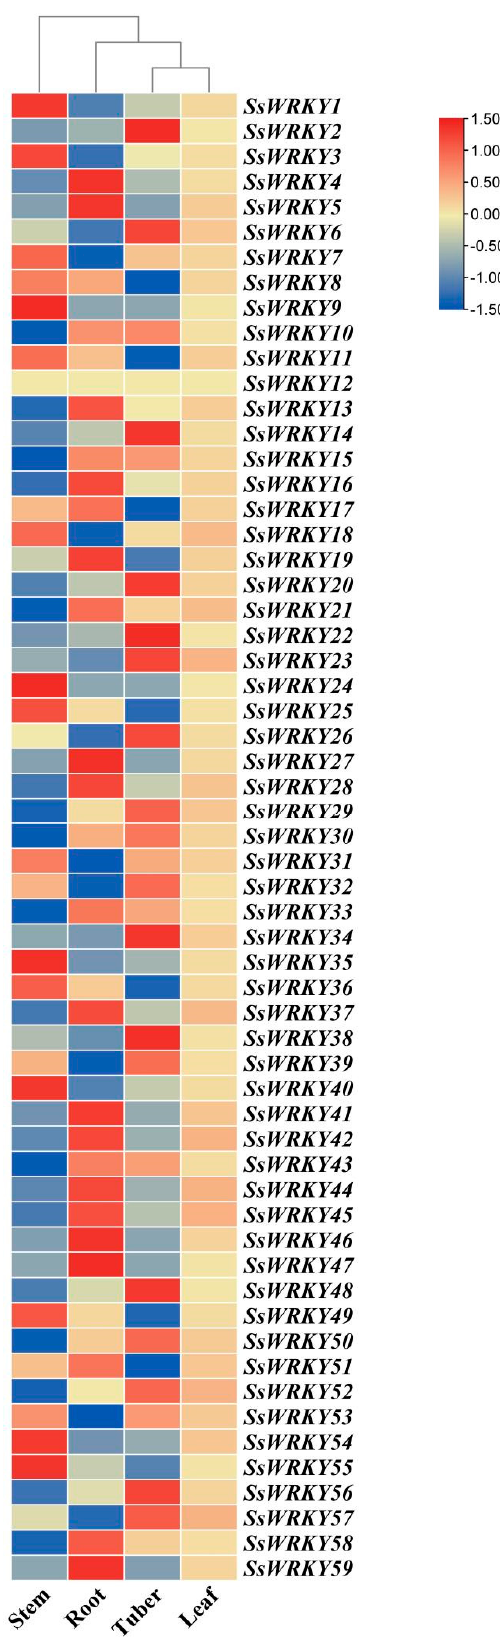
Figure 8. Expression patterns of SsWRKY genes in four different tissues of S. siamensis . RPKM value was assessed to investigate the expression levels of SsWRKY genes in stems, roots, tubers, and leaves. The color variation from blue to red represents low to high expression. Our findings will provide references for the function and regulation mechanism of the WRKY gene family in other